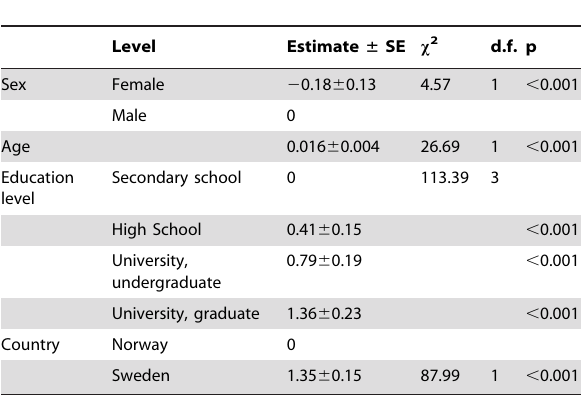
Table 5. The model of the effect of respondent’s characteristics on acceptance of illegal hunting at the individual level presented with estimates from the logit link function and binomial